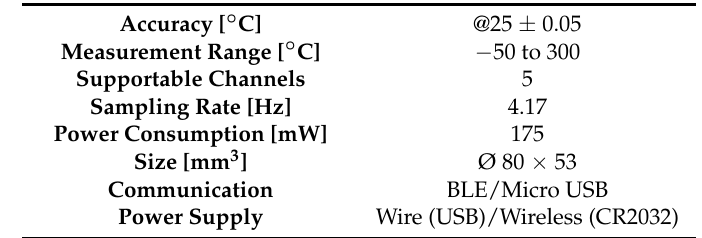
Table 3. Specifications of the temperature sensing probe.